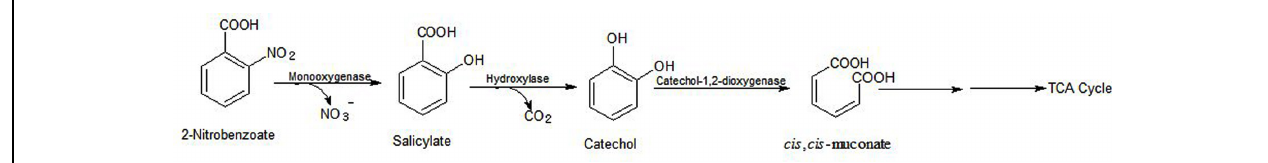
FIGURE 5 | Proposed pathway of the 2NB degradation for Arthrobacter sp.